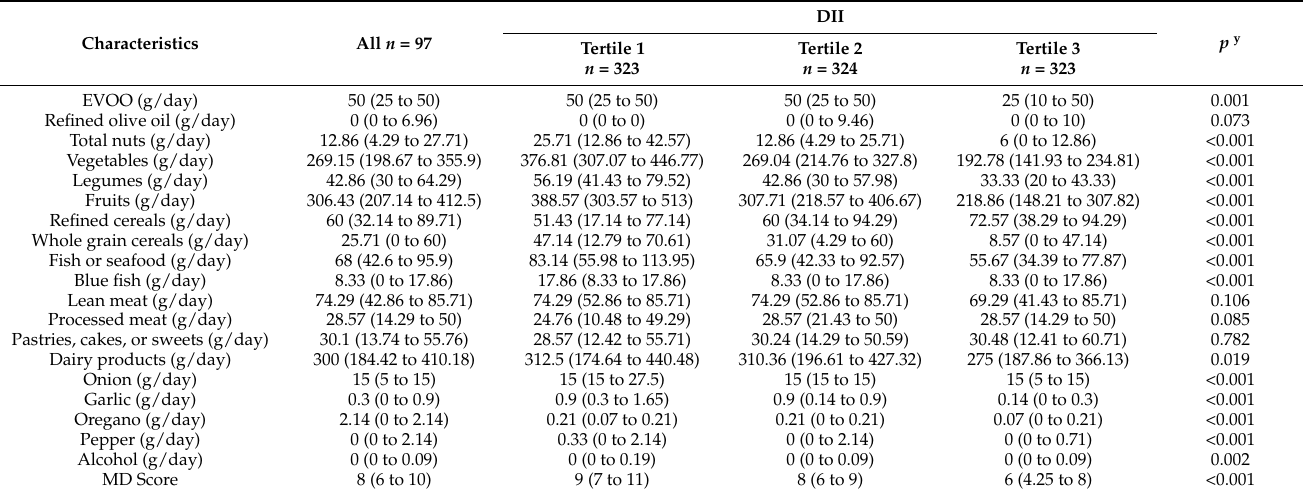
Table 2. Main food intake according to DII score tertiles ( n = 970).